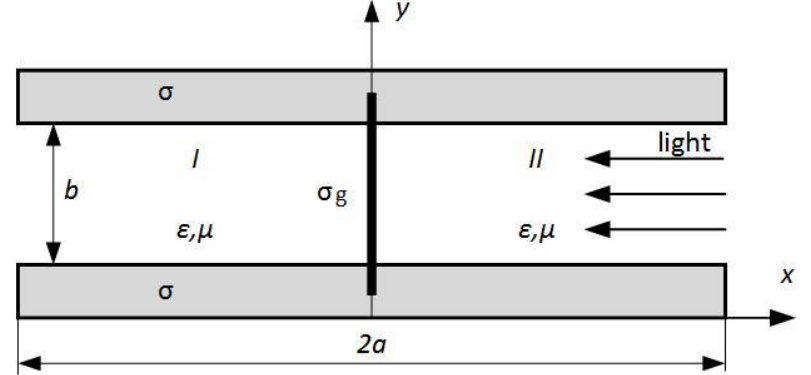
Figure 1. Cross-section of a graphene H-waveguide for lasing application. The terahertz waveguide modes propagate along the z axis, which is normal to the picture plane.